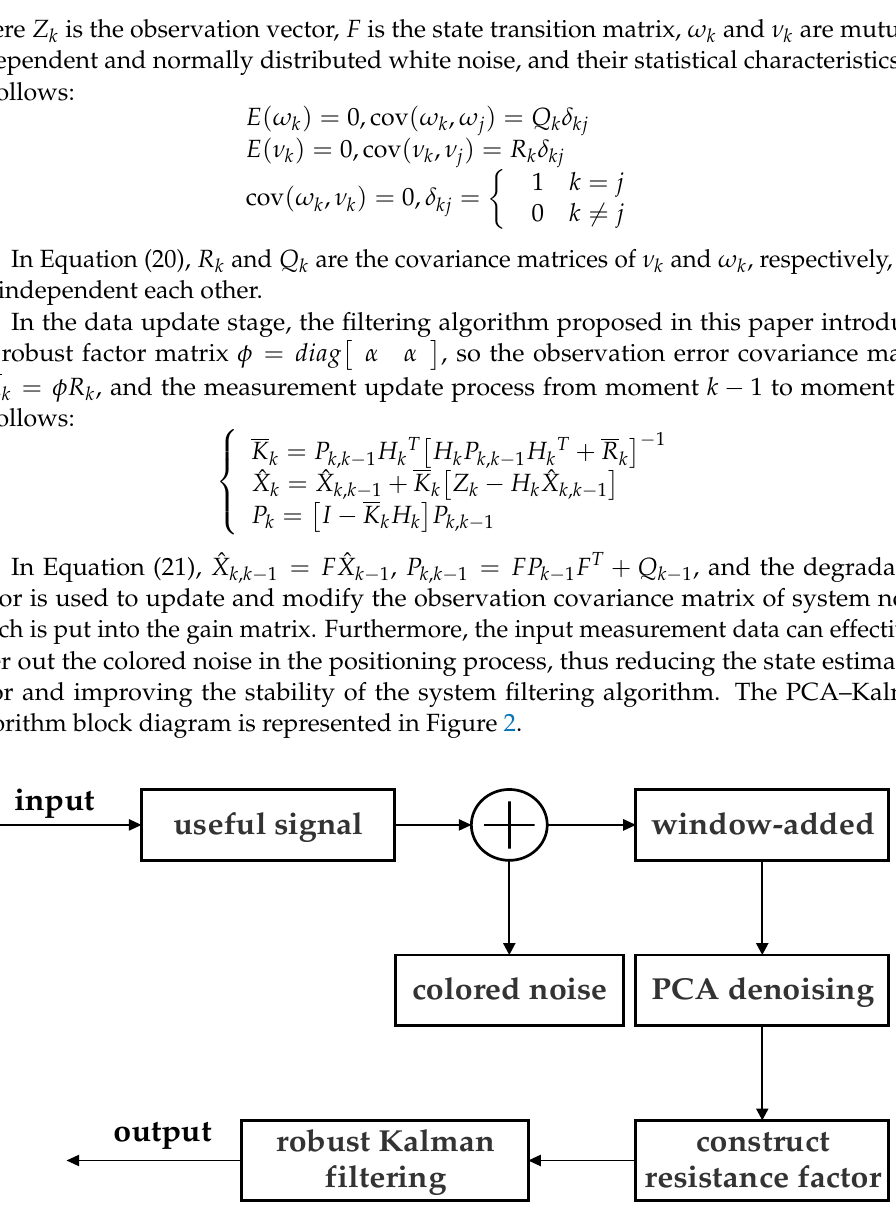
Figure 2. PCA–Kalman algorithm block diagram.